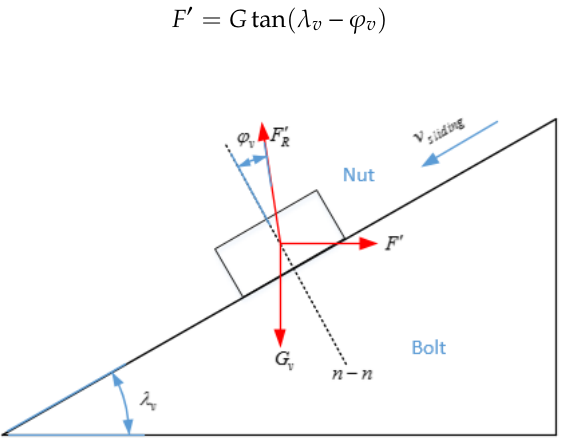
Figure 4. Kinematic relationship between screw and nut during loosening.